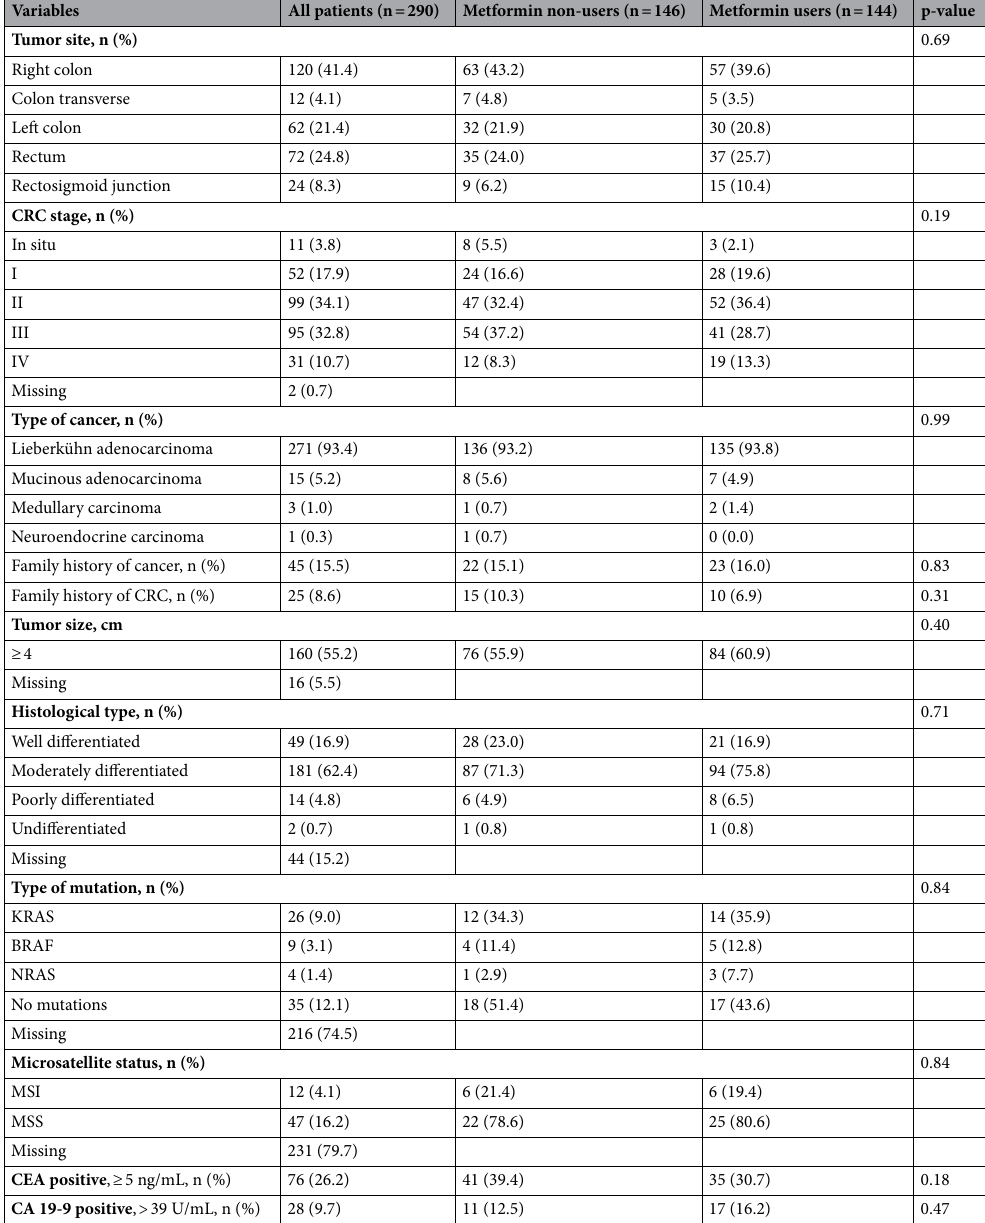
Table 2. Main characteristics of CRC patients with type 2 diabetes mellitus compared by metformin status Subgroup analyses. Figure 3 summarized the effect of metformin on DFS in different subgroups in multi- variate analysis. The use of metformin was associated with better DFS in stage II CRC (aHR = 0.09; 95% CI: 0.02– 0.42), stage III (aHR = 0.33; 95% CI: 0.14–0.82), colon cancer (aHR = 0.35; 95% CI: 0.18–0.66) and rectal cancer subgroup (aHR = 0.30; 95% CI: 0.09–0.98, Fig. 3). Furthermore, among metformin users, having a BMI ≥ 25 had no effect on DFS compared with a normal BMI (aHR = 0.43; 95% CI: 0.17–1.09). In multivariate analysis, the use of metformin in combination with other antidiabetic drugs was not associated with OS (aHR = 2.17, 95% CI: 0.49–9.59) nor DFS (aHR = 0.68, 95% CI: 0.23–2.01) compared with metformin users alone. Comparison of the survival of metformin users according to their microsatellite status. Among patients with MSS, metformin users had an improved DFS compared to non-users (62.3 ± 10.0% vs. 22.2 ± 9.8%; p = 0.03). However, there was no significant differences between metformin users and non-users in patients with MSI (83.3 ± 15.2% vs. 80.0 ± 17.9%; p = 0.95).